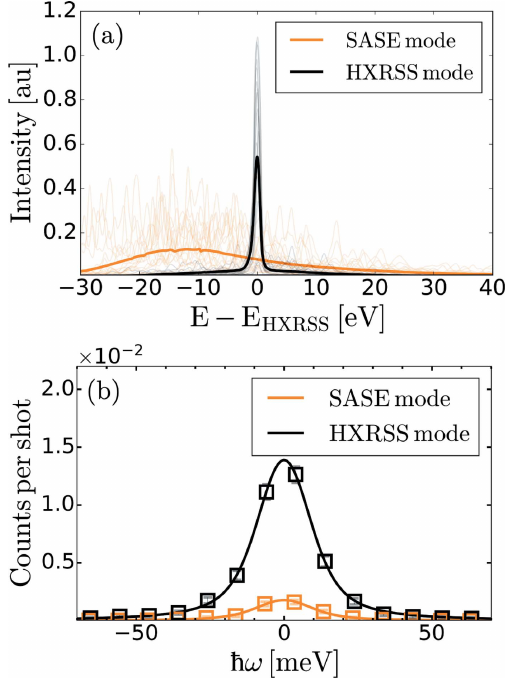
Figure 3 ( a ) Example spectra of the SASE beam mode (orange) and the HXRSS beam mode (black). The faint lines correspond to single-shot spectra recorded using a bent silicon spectrometer upstream of the MEC endstation at the LCLS (Zhu et al. , 2012). The thick lines correspond to the average spectra from 10 4 shots. For clarity, only 20 single-shot spectra are shown. ( b ) Number of photons scattered from a 50 m m-thick PMMA sample at Q = 3.5 A˚ (cid:4) 1 using the SASE beam mode (orange squares) and using the HXRSS beam mode (black squares). The solid line corresponds to a fit to the experimental data using a pseudo-Voigt